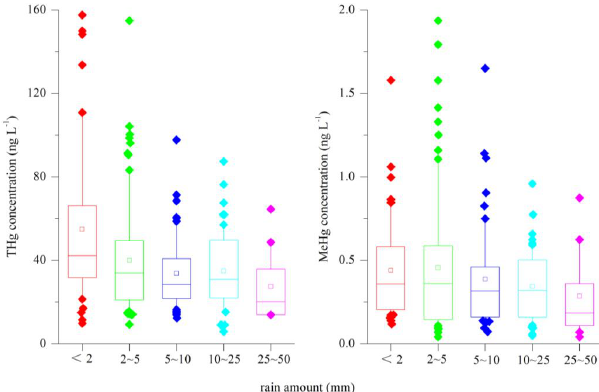
Fig. 7. THg and MeHg concentrations in precipitation collected from three sampling sites grouped together according to different rain